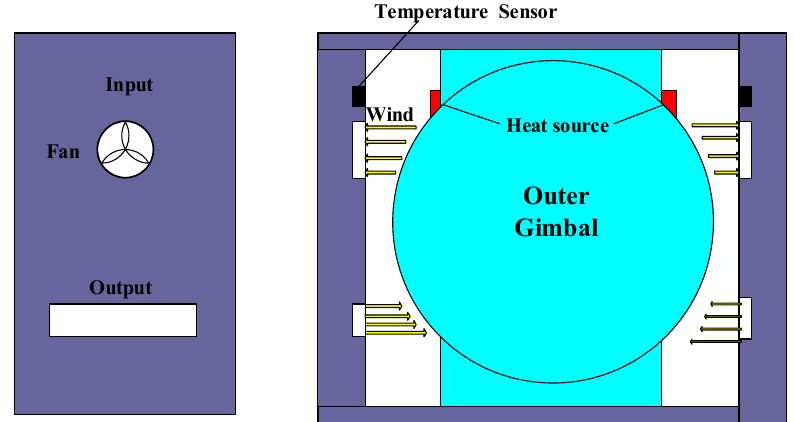
Figure 2. Structure of temperature control system of our high-precision platform INS.